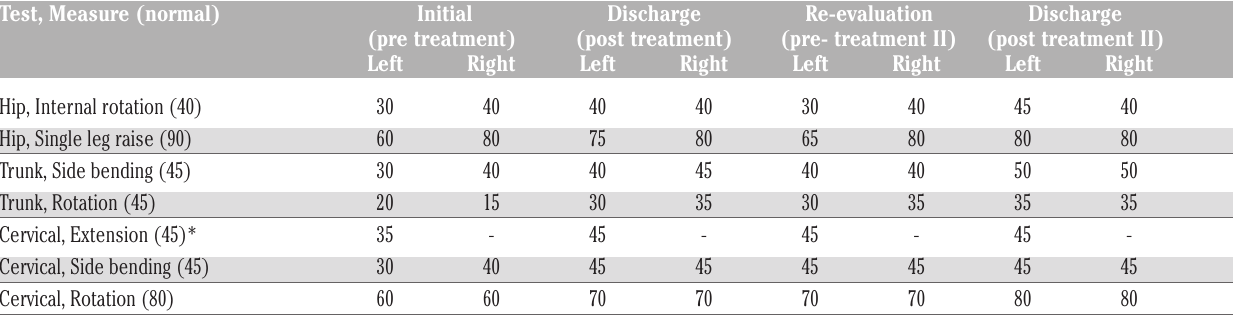
Table 2. Range of motion measurements demonstrating improvements in tests identified as not within normal limits at the initial eval- uation. Test, Measure